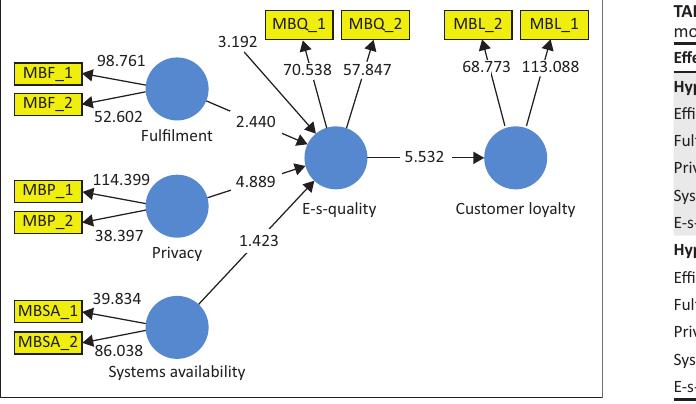
FIGURE 5: Partial least squares path model for mobile banking application.